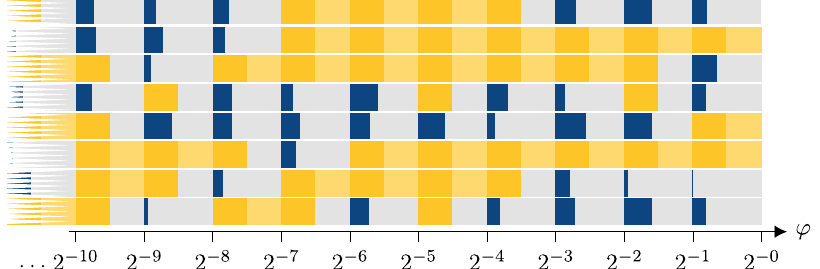
Fig. 1 A selection of sample phase diagrams of the continuous family { H Λ ( L )( φ )} L , φ written for a series of possible universal encoded Turing machines varying from top to bottom, plotted against φ on the x -axis (note the log scaling). Blue means gapless (which is where the TM halts asymptotically on input φ ) and yellow gapped (TM runs forever). At the points 2 − η for η 2 N , we can have a phase transition between gapped and gapless